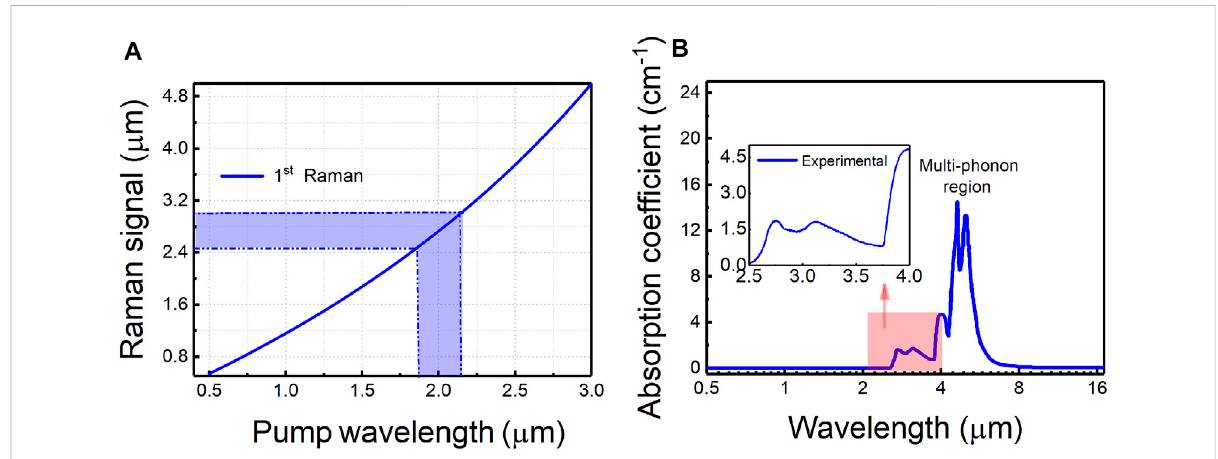
FIGURE 1 (A) Raman signal versus the pump wavelength. (B) Absorption spectrum of the